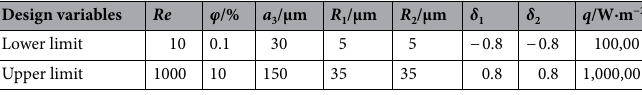
Table 3. Varying scope for design parameters.